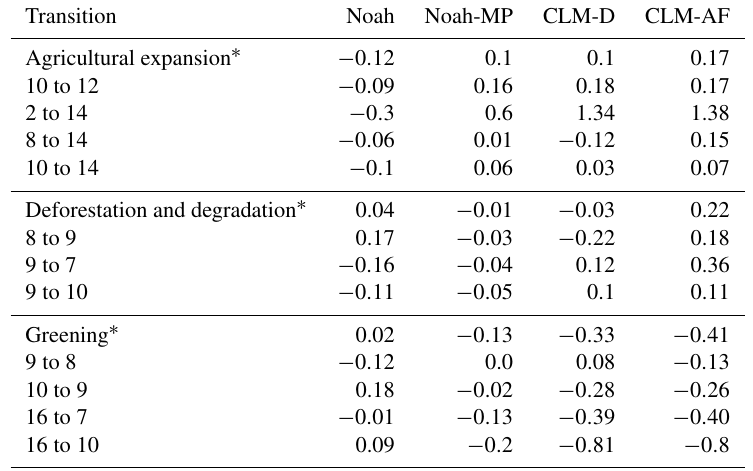
Table 10. Annual average 2m temperature change ( ◦ C) in WRF grid cells that experience LULCCs between 2001 and 2010–2015. Transition Noah